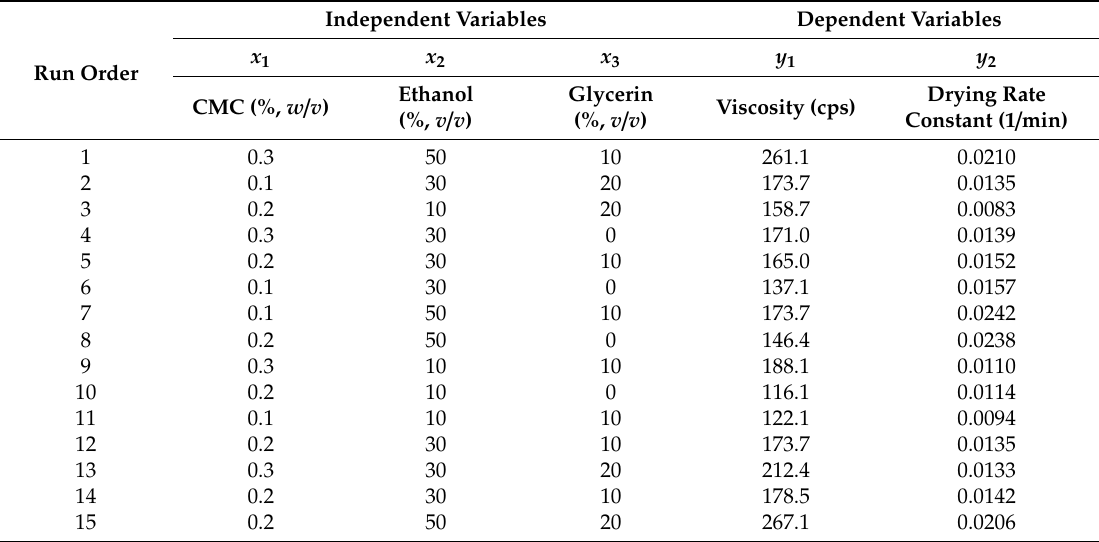
Table 1. Experimental combinations of independent variables and observed responses in Box-Behnken design.